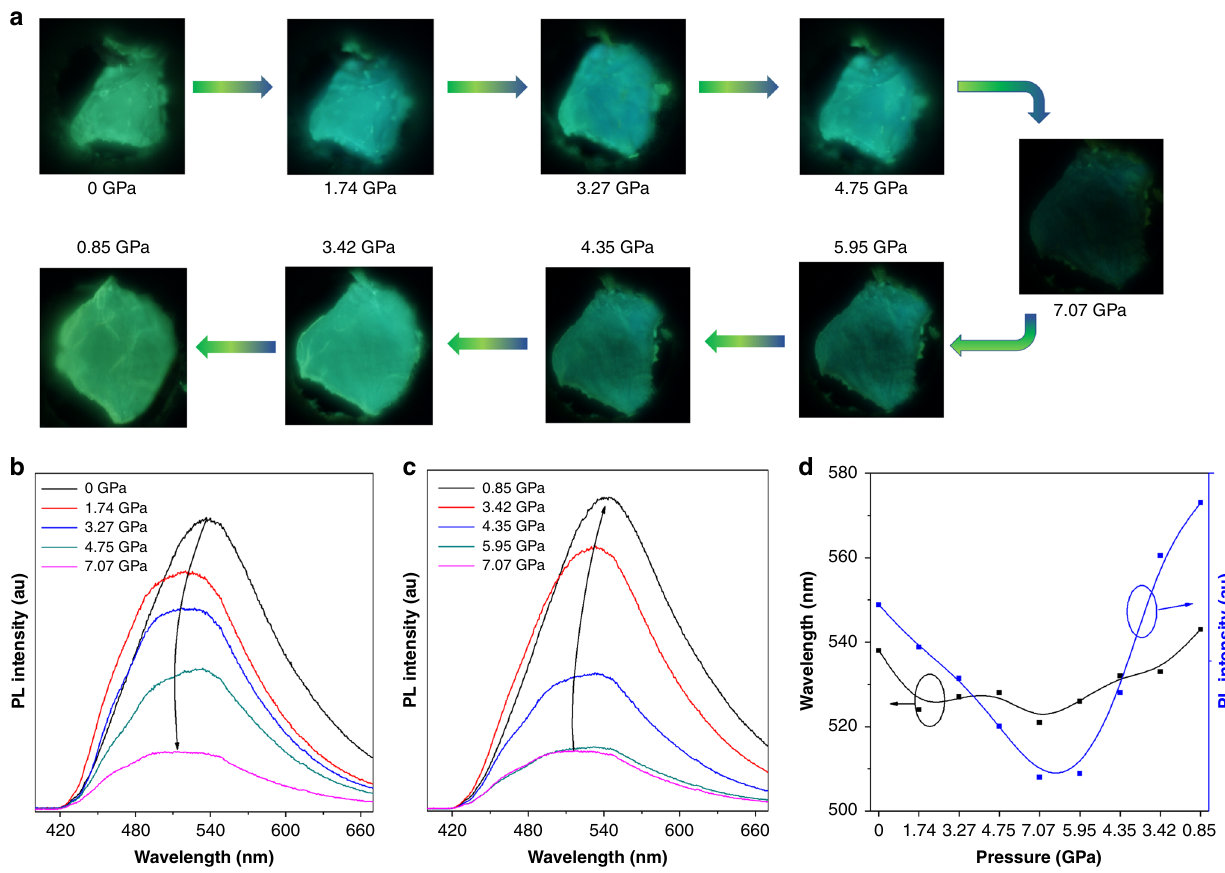
Fig. 7 Fluorescence changes upon varied hydrostatic pressure. a Micrographs of the crystal under high pressure. b Emission spectra recorded during the compression process in the range of 0 − 7.07 GPa. c Emission spectra recorded the decompression process in the range of 7.07 − 0.85 GPa. d Plot of the emission wavelength (black dot line) and PL intensity (blue dot line) vs. the hydrostatic